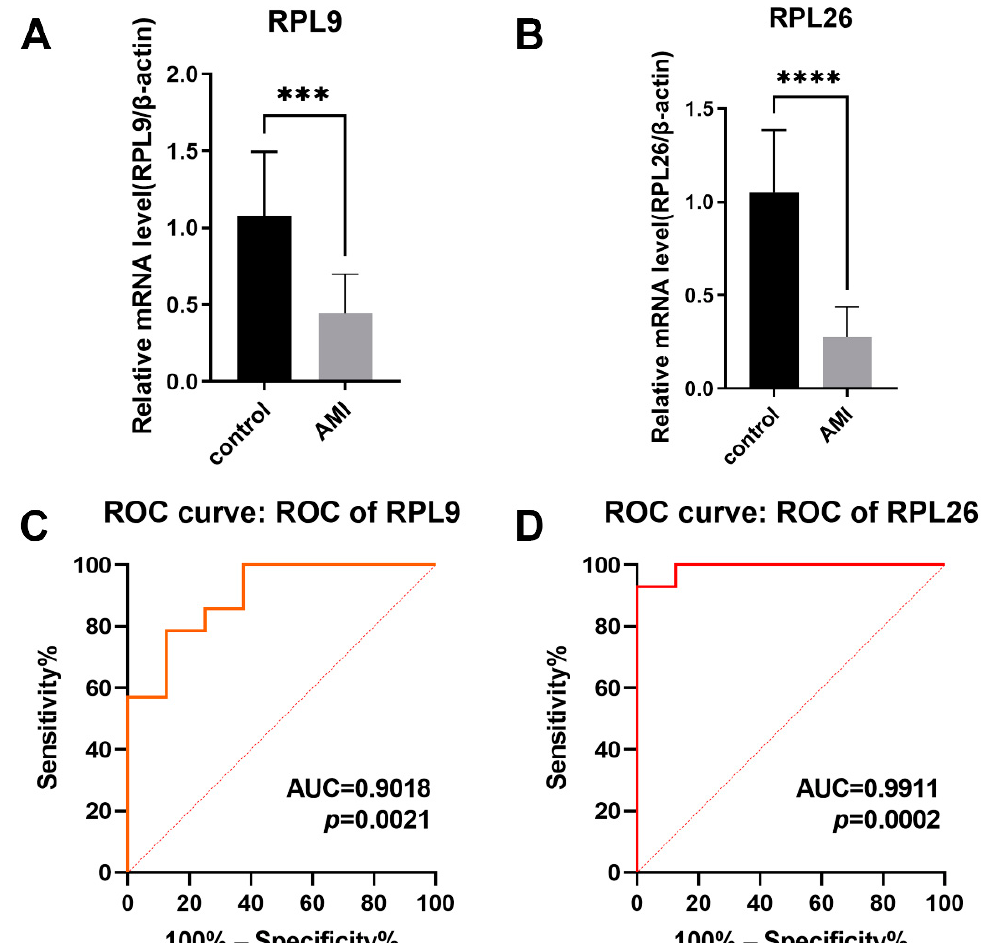
Figure 8. Validation of hub genes. ( A ) Relative mRNA level of RPL9 in controls vs. AMI patients. ( B ) Relative mRNA level of RPL 26 in controls vs. AMI patients. (*** p < 0.001, **** p < 0.0001). ( C ) ROC curve for RPL9. ( D ) ROC curve for RPL26.